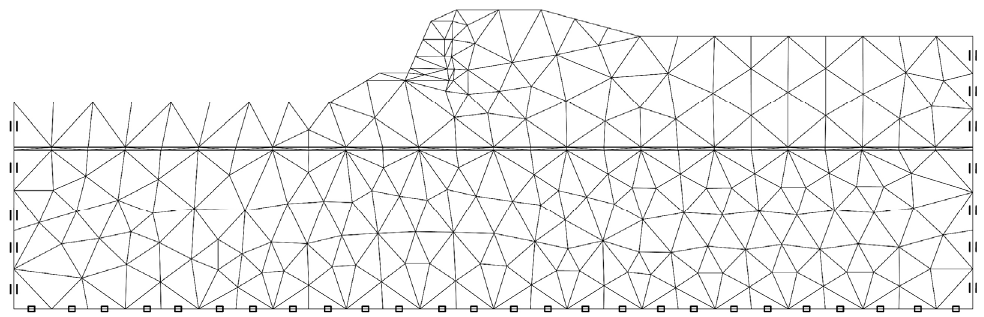
Figure 2. FEM mesh employed for the case of z i /H = 1.18.